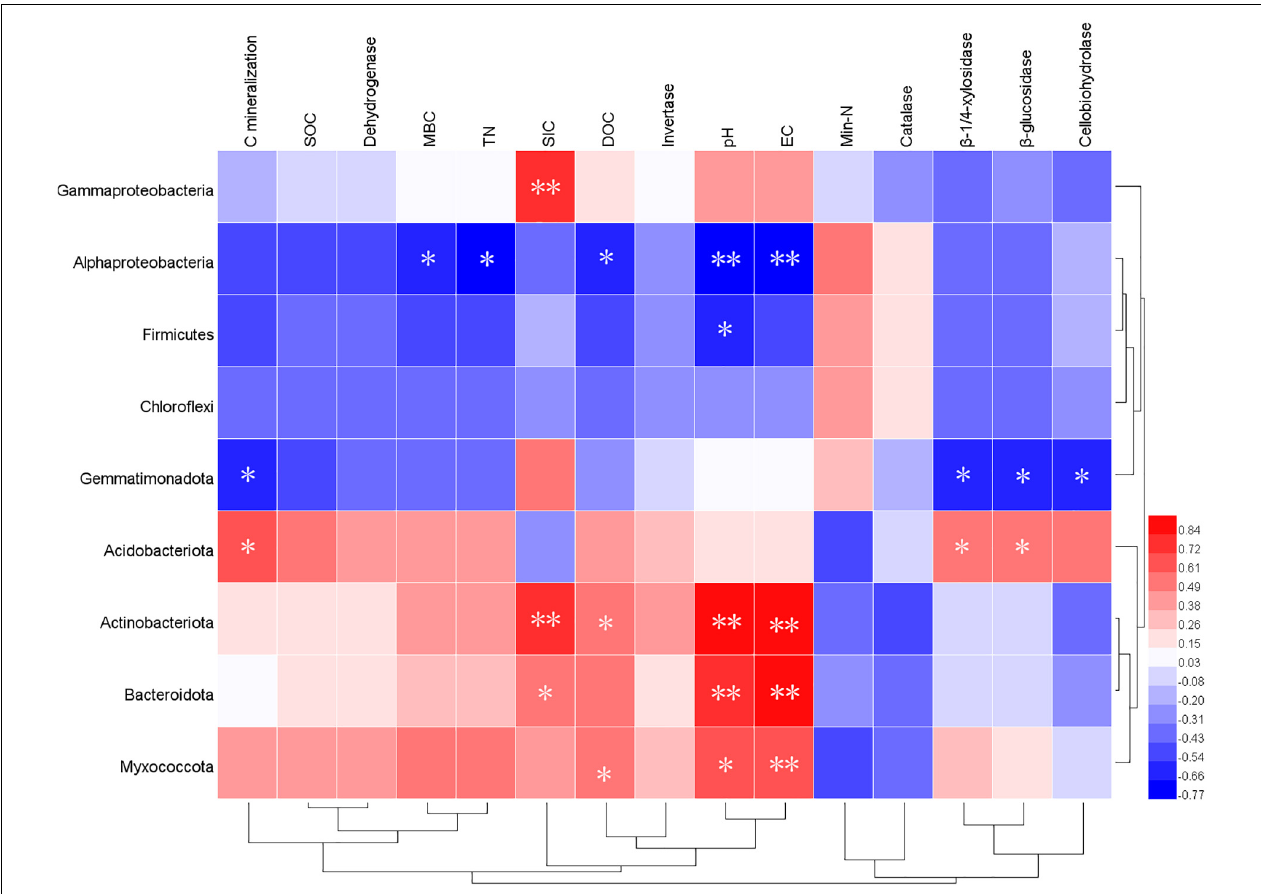
FIGURE 5 | Pearson’s correlation between soil characteristics and the relative abundance of bacterial groups (phylum level). ∗∗ Correlation is significant at the 0.01 level. ∗ Correlation is significant at the 0.05